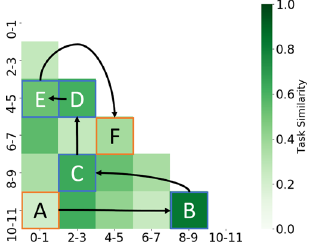
Fig. 5 Similarity of tasks in the Class-IL scenario overlaid with the chain of tasks used for curriculum learning. The curriculum begins with the task identi fi ed as being the easiest ([10 – 11]), which is chained to similar tasks by following the arrows, and concludes with the task identi fi ed as being the most dif fi cult ([6 – 7]). The effect of such a curriculum on the learning process can be found in Table 3. Table 3 Effect of various curricula on the performance of the continual deep-learning system in the Class-IL scenario. Task order Random